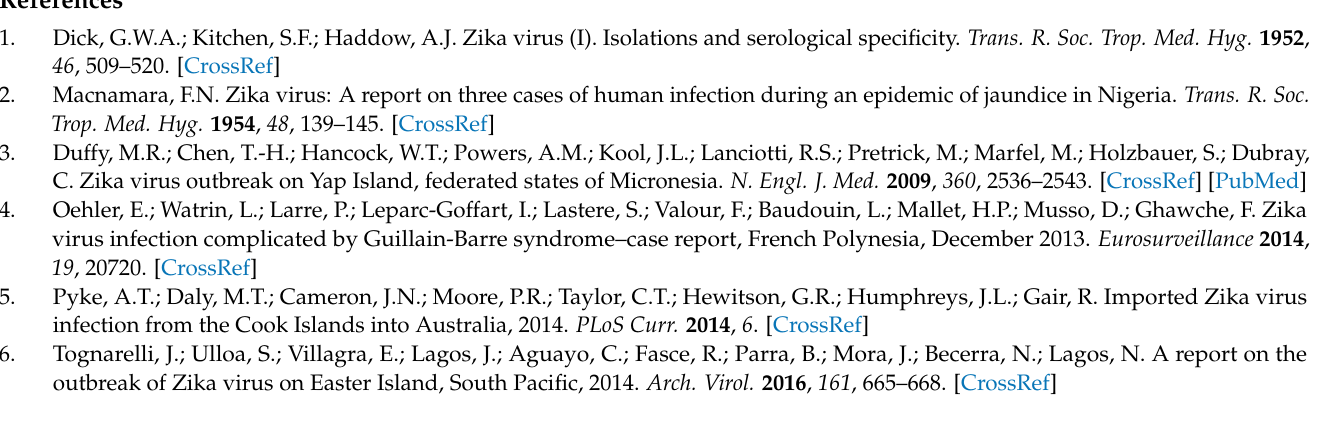
Median and 95% HPD of estimated introductions, as calculated by MCC Tree, from Pernambuco to other Brazilian